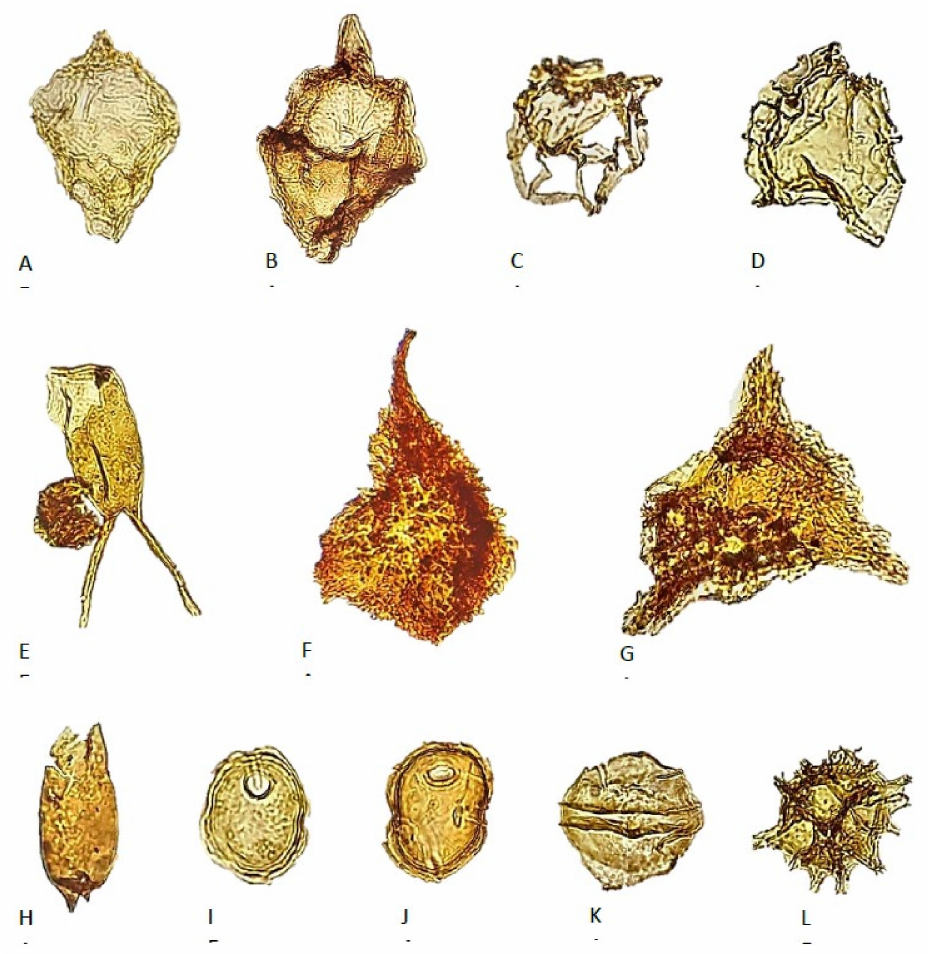
Figure 10. Dinoflagellate cysts and acritarchs from boreholes Bh 2 and Bh 3. ( A ) Tubotuberella apatela , Bh 2, 166.4 m (7), width YY µ m. ( B ) Scriniodinium sp., Bh 2, 116.5 m (4), width YY µ m. ( C ) Hapsocysta sp. I, Bh 2, 115.1 m (3), width YY µ m. ( D ) Sirmiodinium grossii , Bh 2, 25.0 m (6), width YY µ m. ( E ) Batioladinium longicornatum , Bh 2, 102.05 m (5), width YY µ m. ( F ) Pseudoceratium anaphrissum , Bh 2, 115.1 m (2), width YY µ m. ( G ) Pseudoceratium iveri , Bh 2, 25.0 m (3), width YY µ m. ( H ) Batioladinium micropodum, Bh 2, 102.05 m (5), width YY µ m. ( I ) Cyclopsiella nordlandensis , Bh 3, 169.8 m (3), width YY µ m. ( J ) Cyclopsiella nordlandensis , Bh 3, 176.05 m (2), width YY µ m. ( K ) Ambonosphaera ? sp., Bh 2, 97.15 m, width YY µ m. ( L ) Spiniferites sp., Bh 2, 25.0 m (6), width YY µ